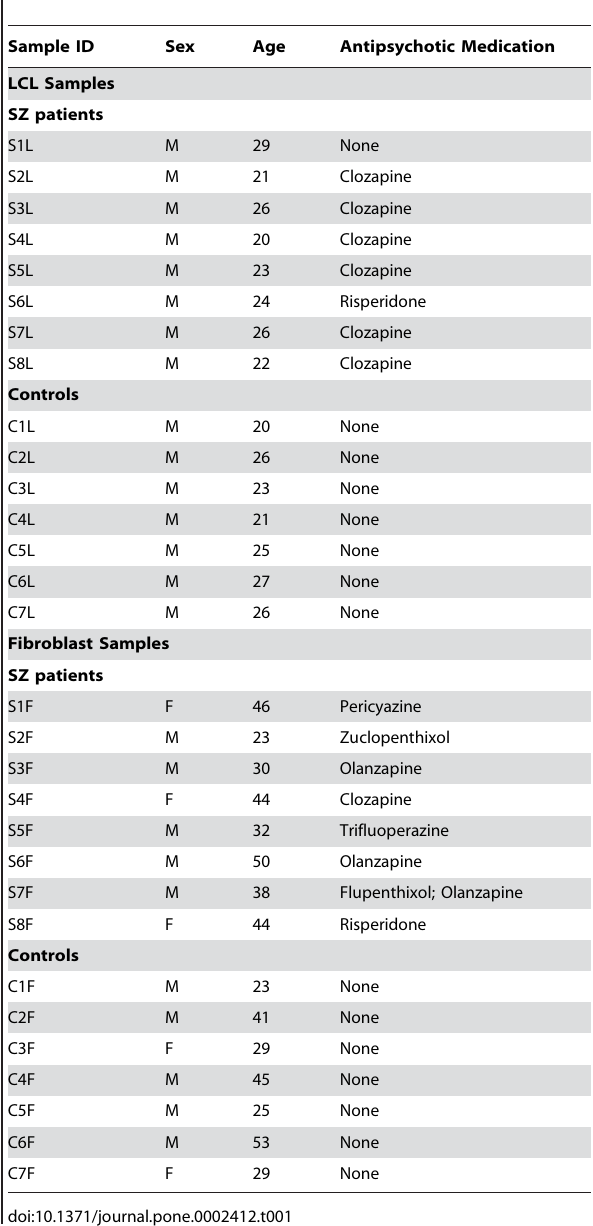
Table 1. Information on schizophrenia patient and control